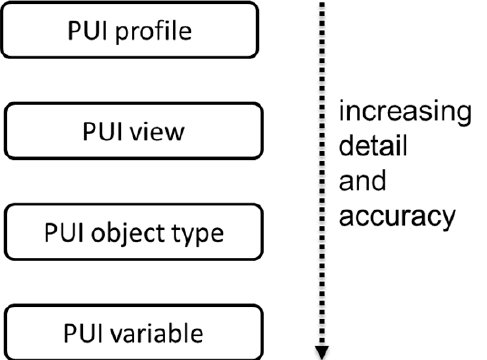
Figure 4. Information content specification of PUI in different detail levels.